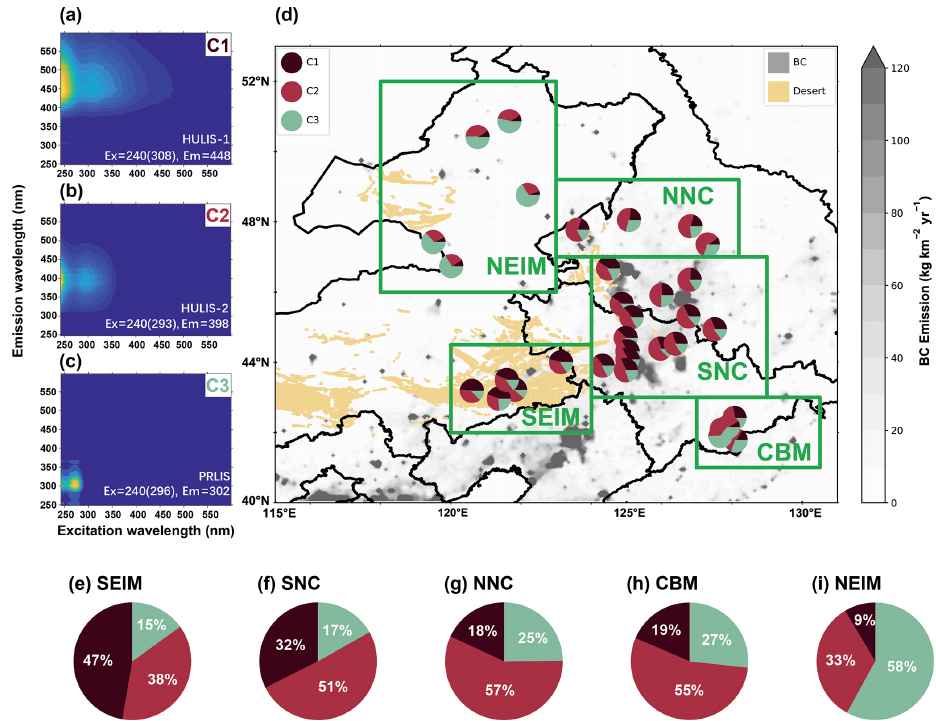
Figure 3. (a–c) Three fluorescent components identified by PARAFAC analysis. (d) Relative contributions of the three components to total fluorescence at each site. HULIS-1, HULIS-2, and PRLIS are represented by the specific colors shown in the legend (top left corner). The distributions of BC emissions and desert areas in our study area are indicated by gray and light yellow, respectively, with darker gray colors indicating higher black carbon concentrations. (e–i) Average contributions of the three components in different groups of samples. BC emission data are derived from the research group at Peking University (http://inventory.pku.edu.cn/home.html, last access: 25 October 2022; Wang et al., 2014a); the Chinese desert (sand) distribution dataset is provided by the National Tibetan Plateau Data Center (http: //poles.tpdc.ac.cn/zh-hans/data/122c9ac2-53ee-4b9a-ae87-1a980b131c9b/, last access: 25 October 2022; Wang et al.,